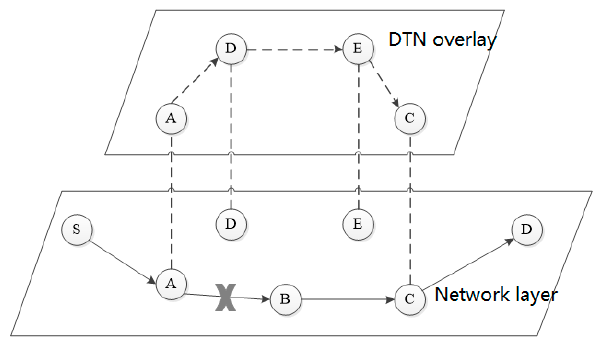
Figure 4. Schematic diagram of packet transmission.